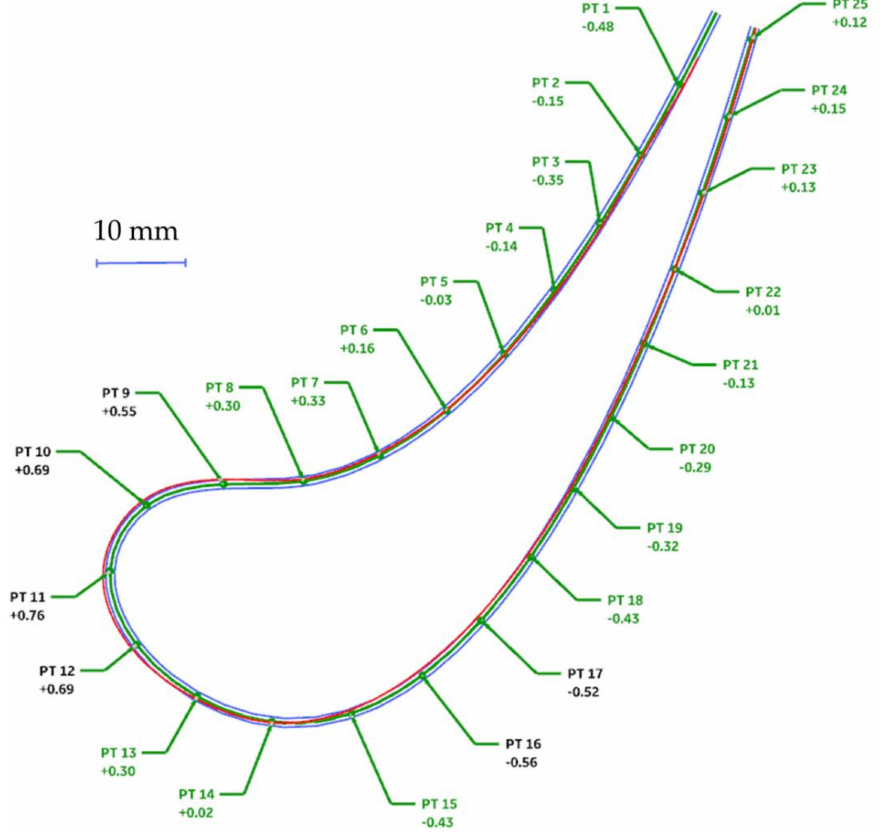
Figure 13. CMM measurement results based on 25 significant points (mm). Simulated curvature based on measurement in